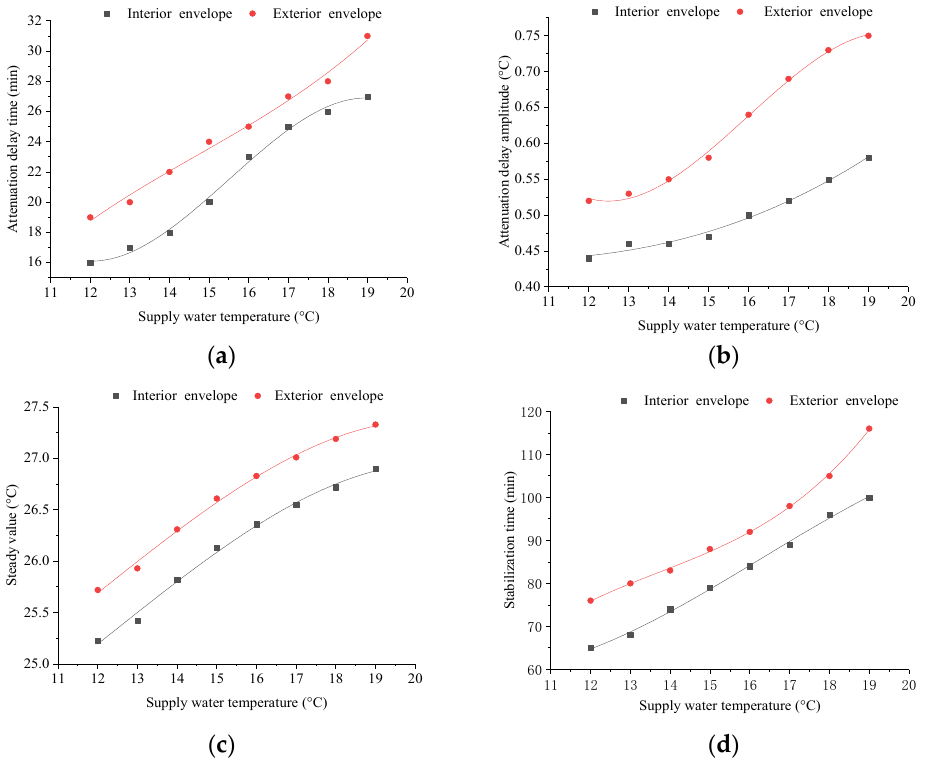
Figure 8. Change in stabilization time ( a ), steady value ( b ), attenuation delay time ( c ) and attenuation delay amplitude ( d ) of the envelope with supply water temperature for CRC system.